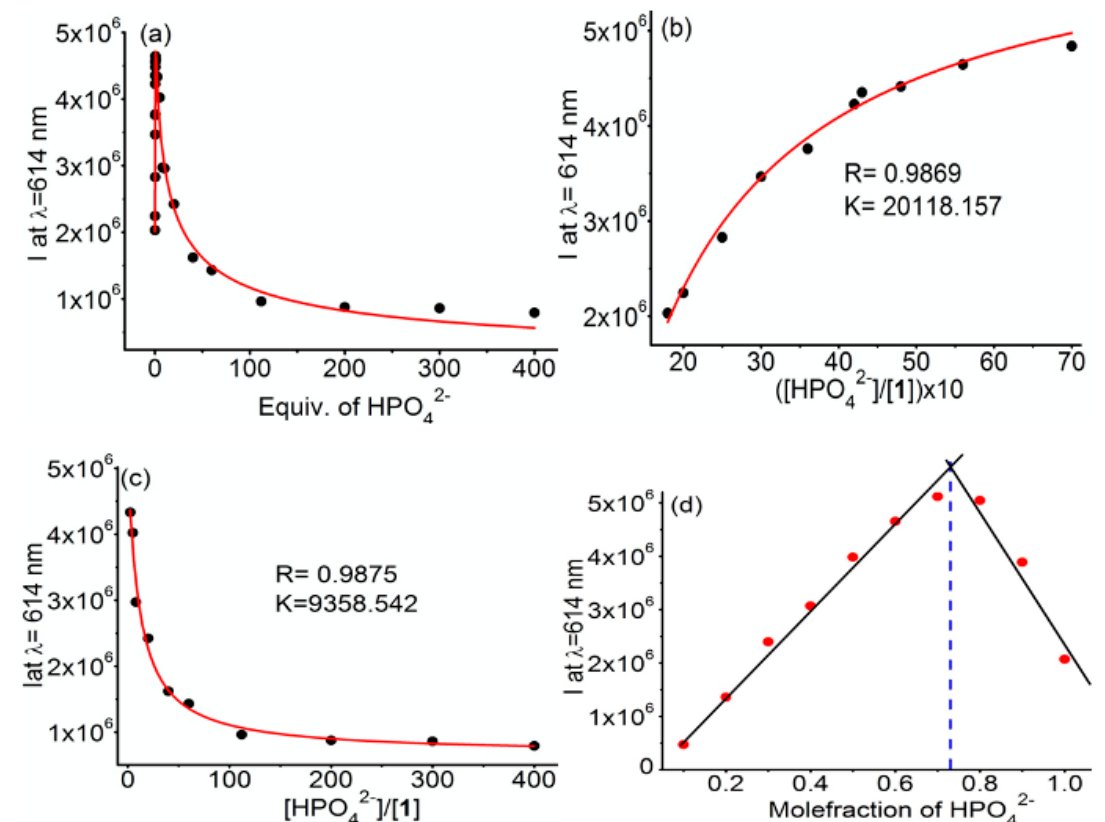
Figure 2. ( a ) Changes in emission maxima of 1 (1 × 10 − 5 M) upon gradual addition of HPO 42 − in aqueous HEPES buffer at pH = 7.4; ( b ) nonlinear curve fitting of the titration data as a function of HPO 42 − concentrations in the range 0.01–1 equiv. (luminescence enhancement part); ( c ) nonlinear curve fitting of the titration data as a function of HPO 42 − concentrations in the range 1–400 equiv. (luminescence quenching part), in which a factor of 10 was multiplied with enhancement to maintain the same intesnsity for both quenching and enhancement; and ( d ) Job’s plot analysis of mixtures of complex 1 with HPO 42 − ( C complex 1 + C HPO 42 − = 1.0 μ M) in aqueous HEPES buffer pH 7.0, indicating 1:2 complex formation ( λ emi = 614 nm).